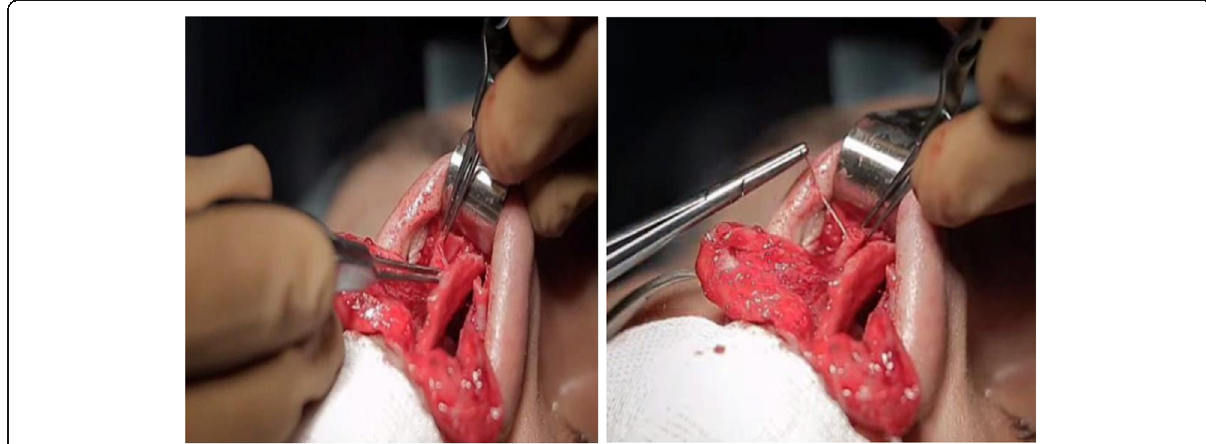
Fig. 3 Folding of the ULC inwards toward the septum in auto-spreader